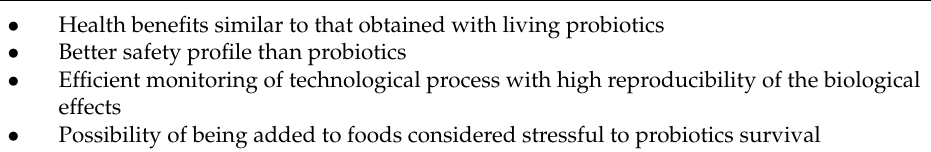
Figure 2. Main receptors recognizing the postbiotic compounds at cell membrane level . Different postbiotic compounds could bind different receptors located on the cell membrane of human cells.